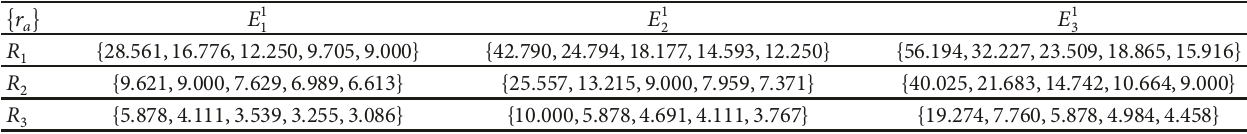
Table 6: The relationship between alternative plans and RPP.